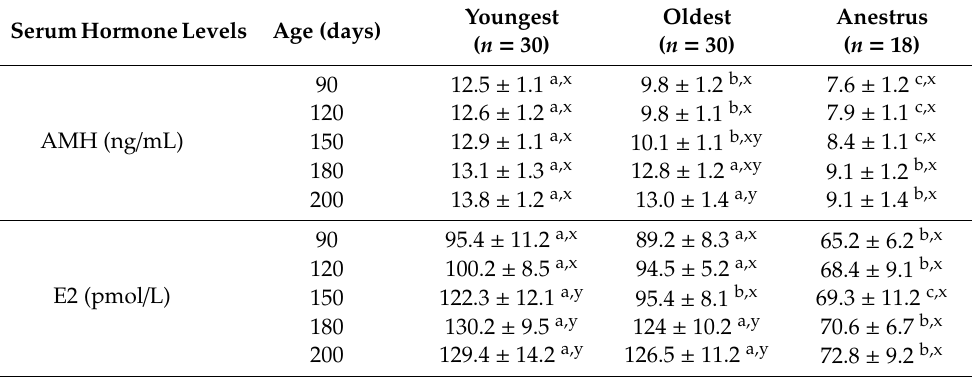
Table 1. Gilt serum concentrations of anti-Mullerian hormone (AMH) and E2 at 90, 120, 150, 180, and 200 days of